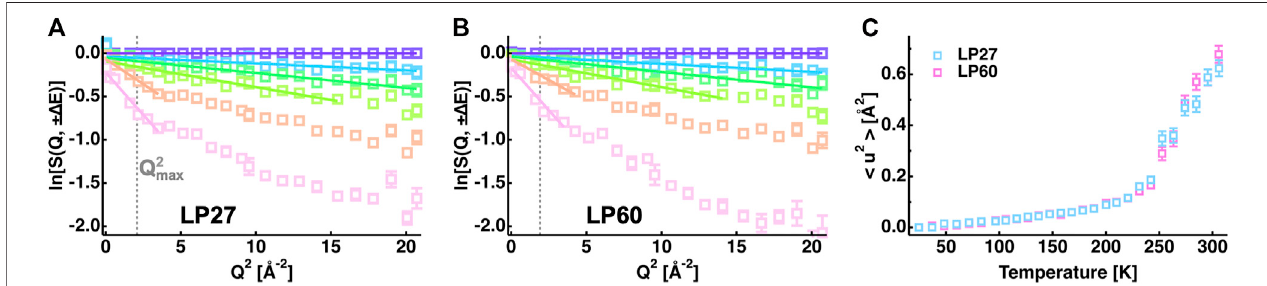
FIGURE4| MSDanalysisoftheEINScurves. (A,B) :Q 2 -dependenceofthelogarithmoftheEINScurvesofLP27 (A) and LP60 (B) normalized bythatat thelowest temperatureof24 K.Thetemperaturesofthesecurvesare24,96,147,200,252,and295 K(fromtoptobottom).ThecorrespondingGaussian fi tsaredenotedbysolid lines. For reference, in (A,B) , Q 2 max values, which are the square of the maximum Q values where the Gaussian approximation is strictly valid ( Q 2 max 〈 u 2 〉 (cid:2) 1 . 3), are denotedbygreydottedlines. Q 2 max wasevaluatedatthehighesttemperatureofeachsample,wherethedecayoftheEINScurveswithincreasingQisthesteepest. (C) :MSDvaluesasafunctionoftemperature.ThoseofLP27andofLP60aredenotedbyopensquaresincyanandmagenta,respectively.Inallthepanels,errorbarsare within the symbols if not shown.